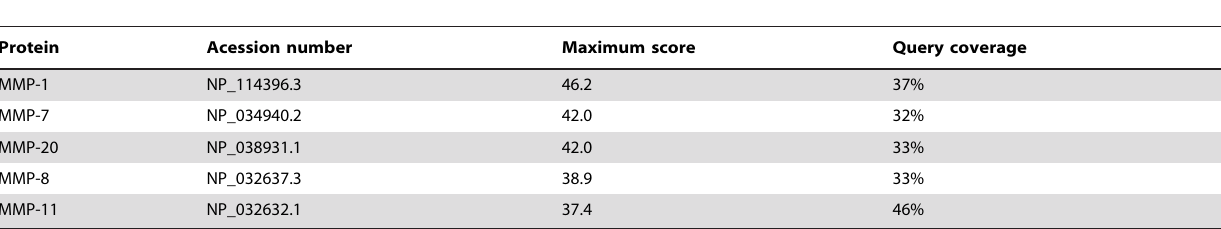
Maximum scores over 30% are showed.